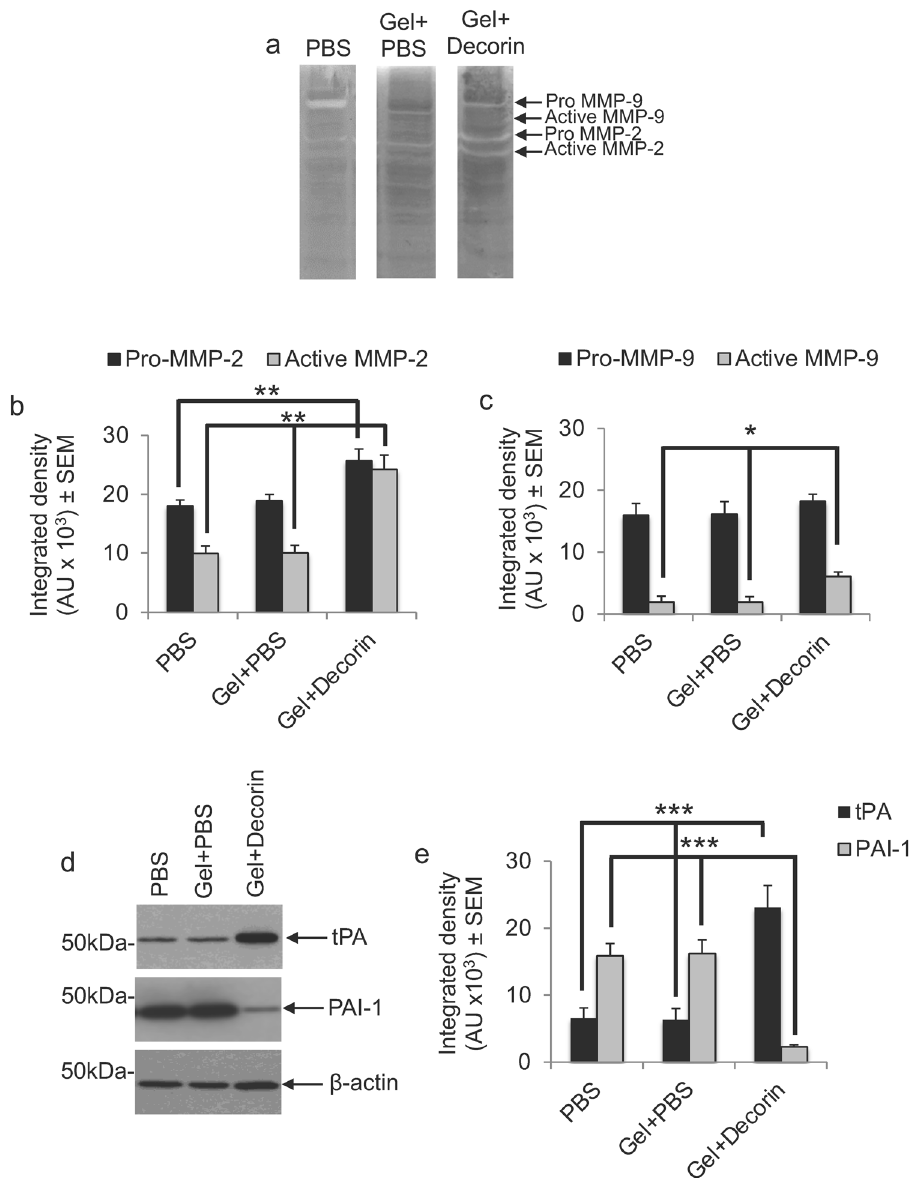
Figure 4. Gel + Decorin enhances MMP and plasminogen activity. ( a ) Zymograms and quantification of ( b ) MMP-2 (pro- and active) and ( c ) MMP-9 (pro- and active) to show enhanced gelatinase activity in Gel + Decorin injected wounds sites compared to wounds treated with Gel + PBS. ( d ) Western blot and subsequent ( e ) quantification to show enhanced tPA, reduced PAI-1 in Gel + Decorin compared to Gel + PBS- treated or PBS alone treated DC wounds. * P < 0.05; ** P < 0.001; *** P < 0.0001, one-way ANOVA with Dunnett’s post hoc test. n = 4 rats/group, 3 independent repeats, total n = 12 rats/group. β-actin was used as a loading control. Original uncropped blots for (a) and (d) are proved as Supplementary Fig. S3 and Supplementary Fig.